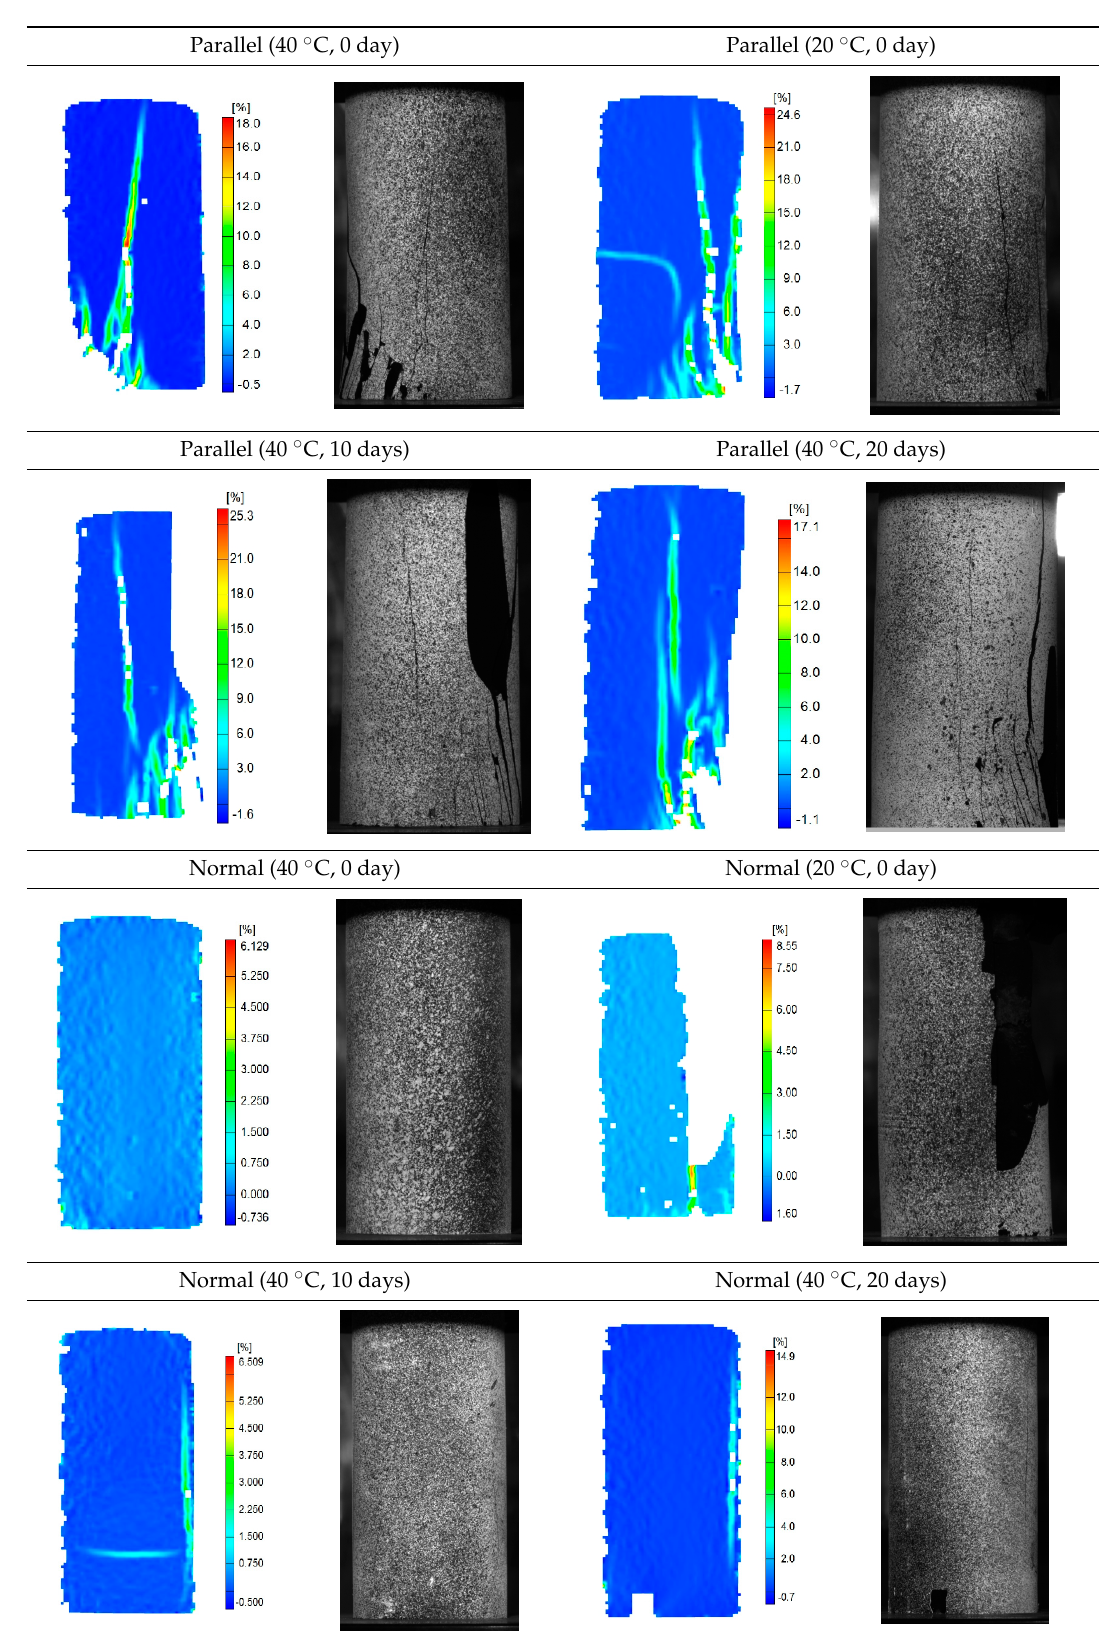
Table 1. The strain distribution and failure mechanism of samples saturated in different conditions.